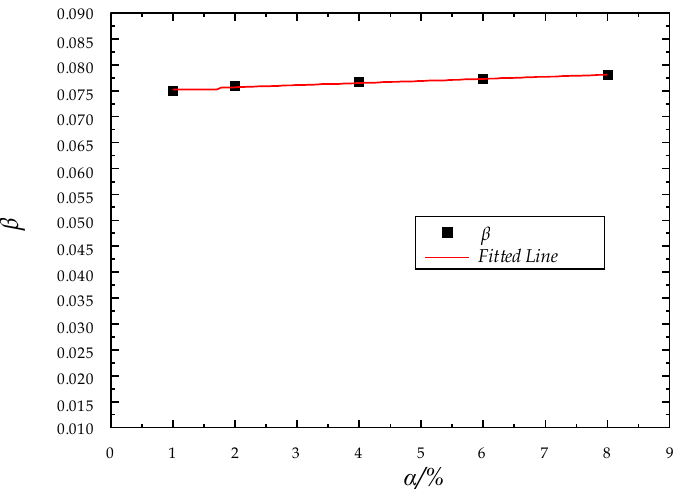
Figure 12. Relationship between the swirl flow decay rate, β , and the initial concentration, α .